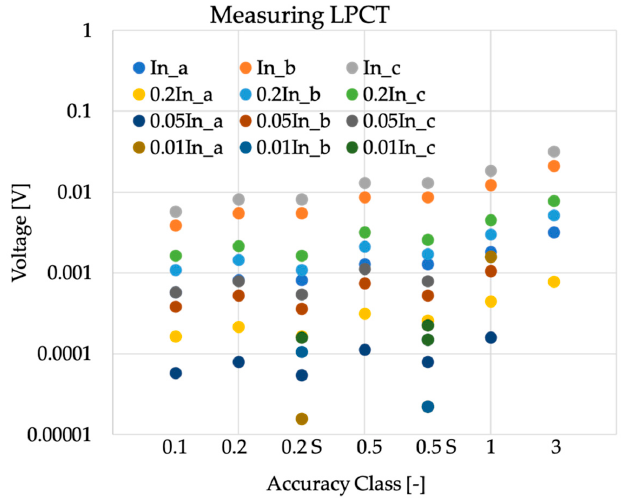
Figure 2. Absolute values of o computed from the rated outputs of Table 1 for measuring purpose current transformers.